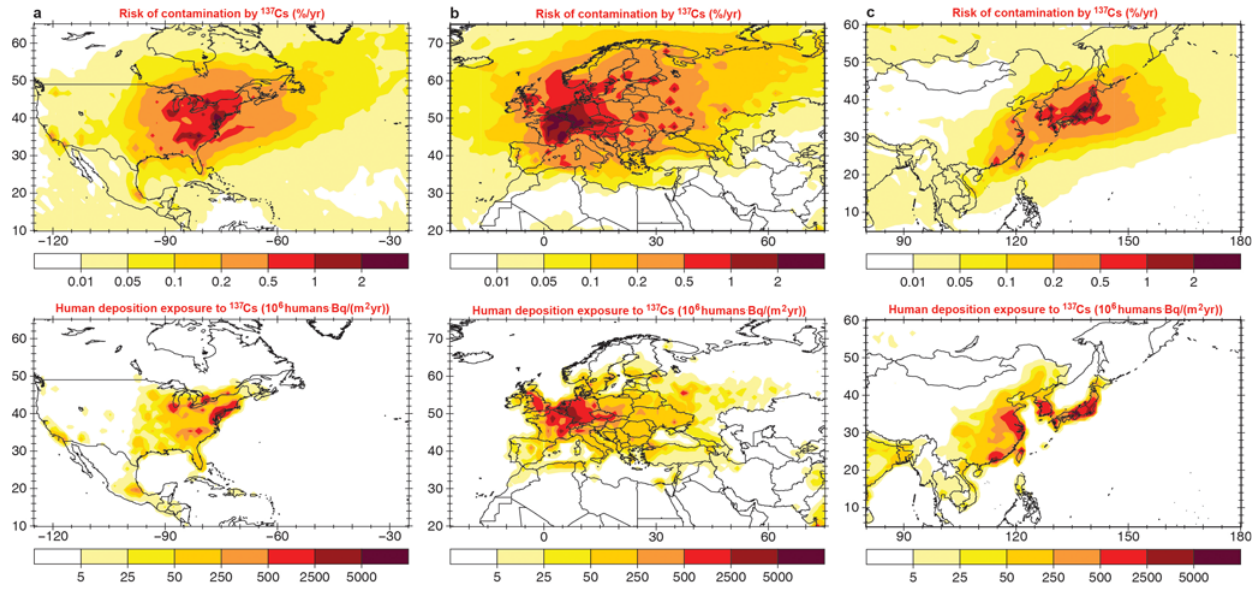
Fig. 3. Regional risks of radioactive contamination by 137 Cs. Same as Fig. 2 for selected regions.